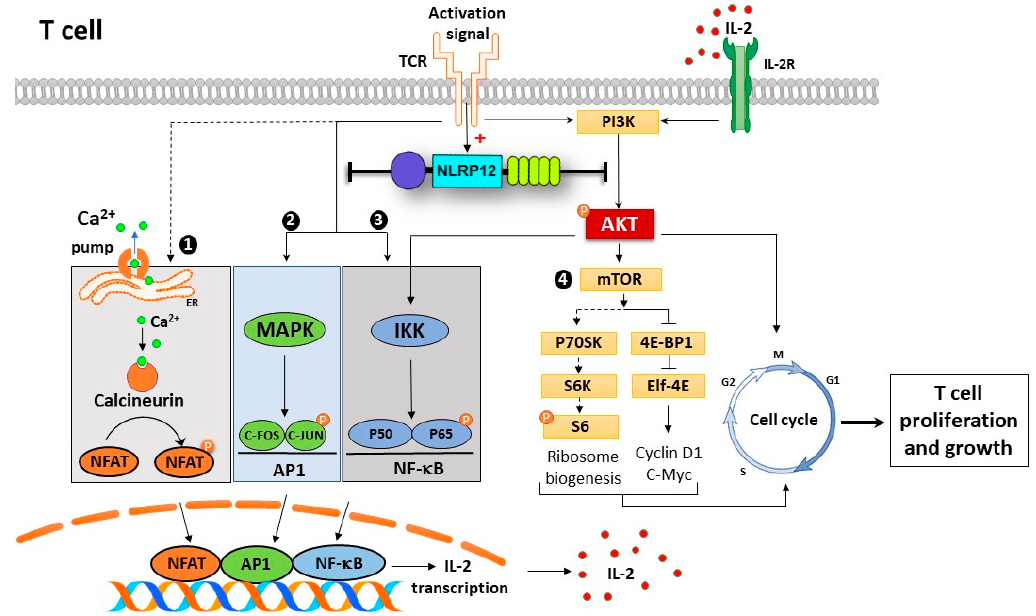
Figure 10. Possible mechanism of action of Nlrp12 in regulating early TCR signaling pathways, T cell activation and proliferation. Activation signals from TCR activates multiple downstream signaling pathways in T cells, presented as (1) NFAT, (2) NF- κ B, (3) MAPK and (4) mTOR pathways. These pathways lead to nuclear translocation of NFAT, NF- κ B and AP1 transcription factors and IL-2 transcription. IL-2 binds to its receptor on the cell surface and initiates mTOR pathway. TCR activating signals induce the expression of Nlrp12 that consequently inhibits NF- κ B and MAPK signaling pathways, which suppress IL-2 production. Upstream of NF- κ B pathway, Nlrp12 inhibits Akt phosphorylation that controls NF- κ B signaling on one side and mTOR activity and cell cycle progression on the other side. Taken together, Nlrp12 has a broad range of regulatory activity that controls hyper-proliferation and activation of T cells. The pathways shown in dashed lines are not affected by Nlrp12 including NFAT signaling and mTOR/S6 phosphorylation.